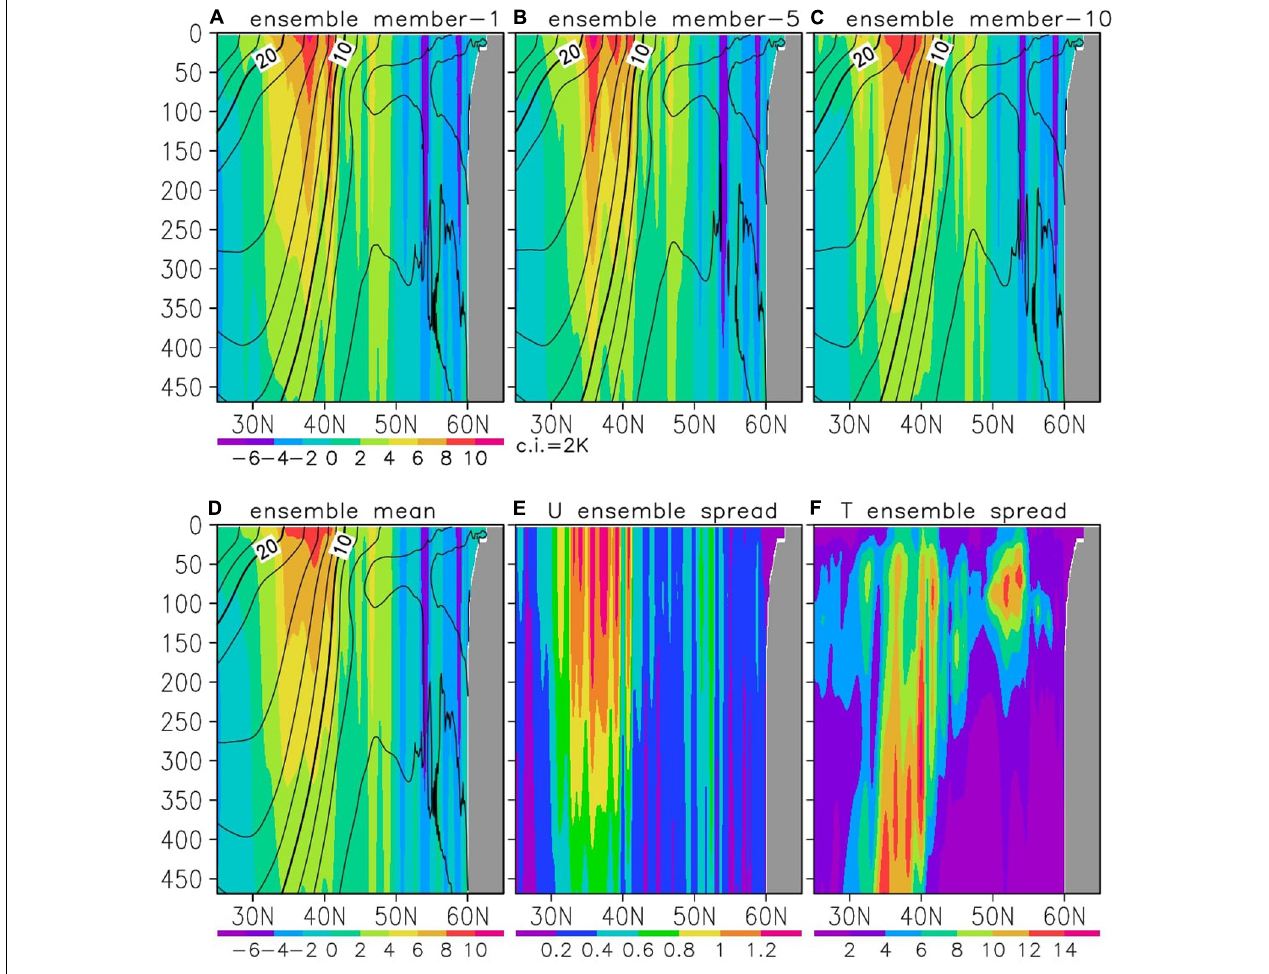
FIGURE 3 | Latitude–depth sections of the long-term (1986–2015) mean, 160 ◦ E–170 ◦ E zonally averaged fields. (A–D) Eastward current speed (shadings, cm s − 1 ) and temperature (contours, with intervals of 2 ◦ C) for panels (A–C) ensembles 1, 5, and 10, and (D) ensemble mean. (E,F) Ensemble spread of panel (E) the eastward current (unit is cm s − 1 ) and (F) temperature (unit is 0.01 ◦ C). Color bar for panels (A–C) is indicated under panel (A)